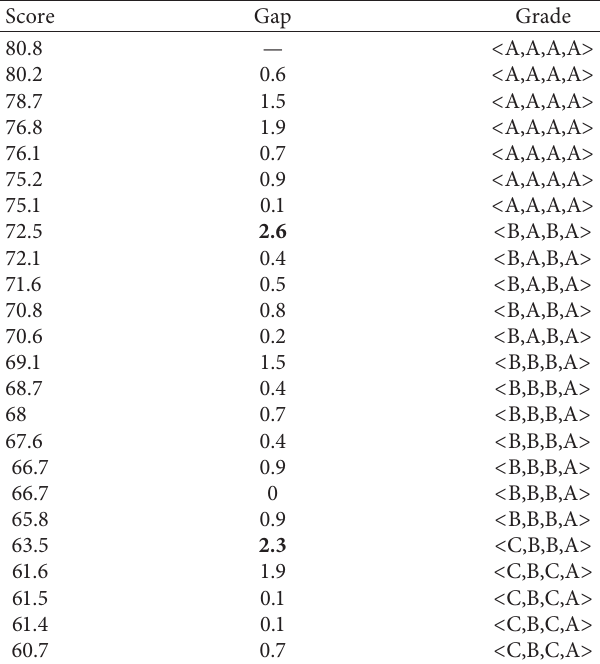
Table 10: Grading results of RD −